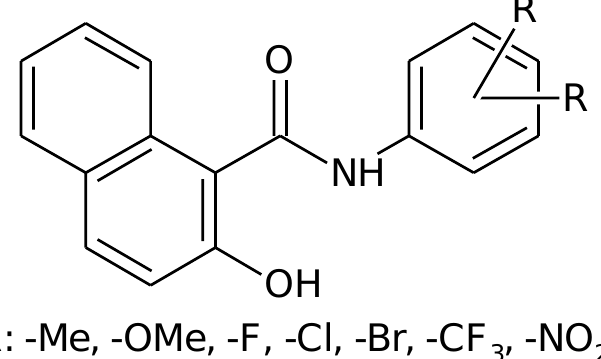
Figure 1. Substituted N -(phenyl-2-hydroxynaphthalene-1-carboxamides.